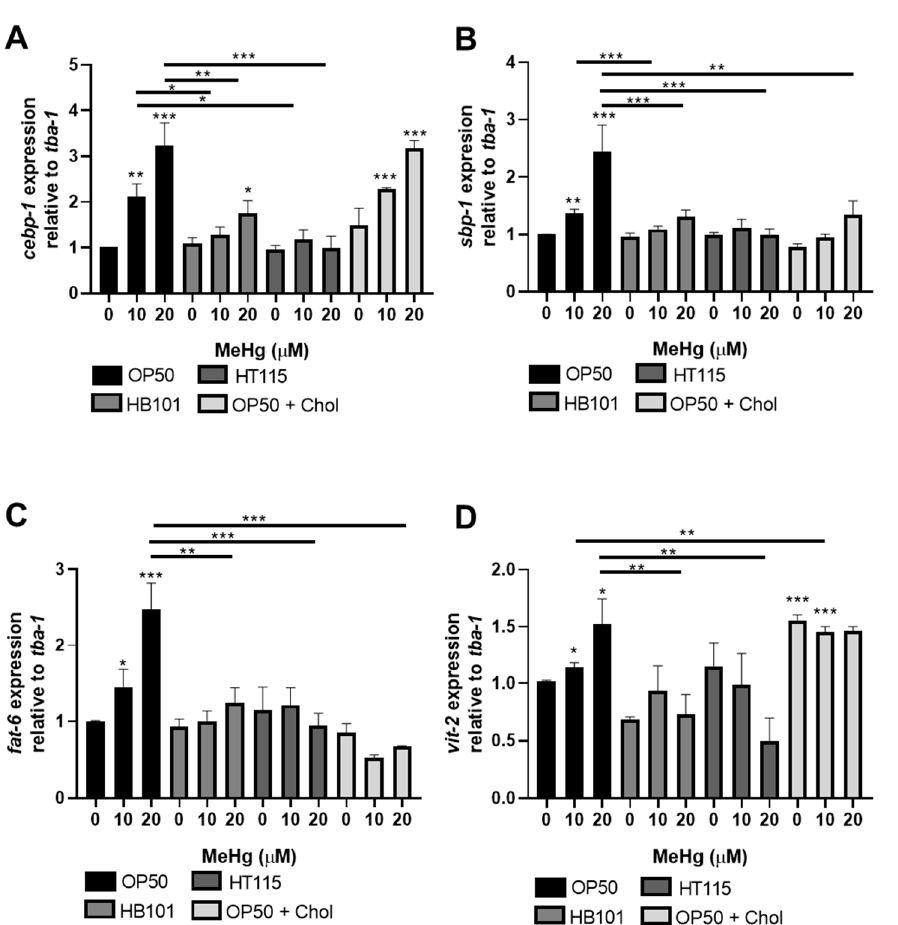
Figure 5. MeHg-induced pro-adipogenic gene expression is dependent on diet. Worms were treated with MeHg for 30 min and placed on NGM plates containing OP50, HB101, HT115, or OP50 supplemented with cholesterol. Then, 72 h after treatment, levels of ( A ) cebp-1 (ortholog of human C/EBP), ( B ) sbp-1 (ortholog of human SREBP-1), ( C ) fat-6 (ortholog to glycerol-3-phosphate acyltransferase), ( D ) vit-2 were measured by quantitative PCR and normalized to tba-1 housekeeping gene. Data are expressed as mean relative expression ± SEM from five independent experiments. * p < 0.05, ** p < 0.01, *** p < 0.001 as compared to untreated OP50-fed control. Horizontal bars represent comparisons between Hg-treated worms fed different diets.